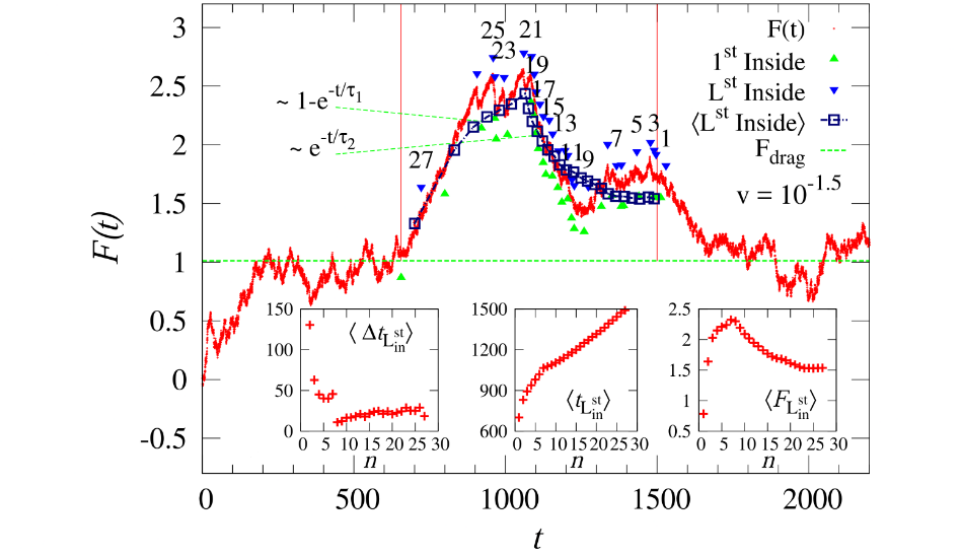
Figure 4. Force trajectory as a function of time for a polymer with 32 monomers. For other system parameters, kindly see the work of Fiasconaro and Falo [163]. The blue (above the curve) and green (below the curve) arrows indicate, respectively, the time of the last and first entrance of the monomer (indexed above the blue arrow) inside the pore. The squares indicate the average force at the entrance events (the last entrance in the case of multiple entrance exits). The horizontal corresponds to the value of the drag force F drag in the absence of pore-polymer interactions and fluctuations. The two (red) vertical lines indicate the time interval over which the mean force is calculated. The three insets correspond to the mean waiting entrance times, the total time spent to enter, and the mean force at the last entrance as a function of the number of monomers that enter the pore, respectively. Reprinted with permission from Fiasconaro and Falo [163] copyright 2018 by the American Physical Society